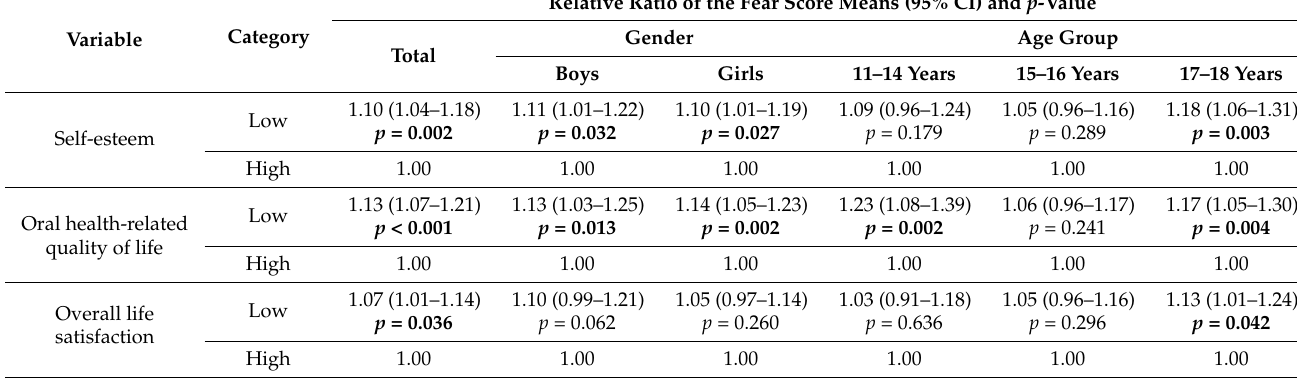
Table 5. Association of child and adolescent dental fear with self-esteem, oral health-related quality of life and overall life satisfaction.